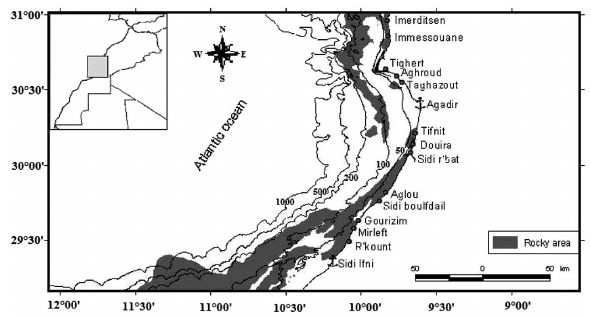
Fig . 1. – Map showing the study area between Immesouane (30°50’N, 09°49’W) in the north and Sidi Ifni (29°21’N, 10°11’W) in the